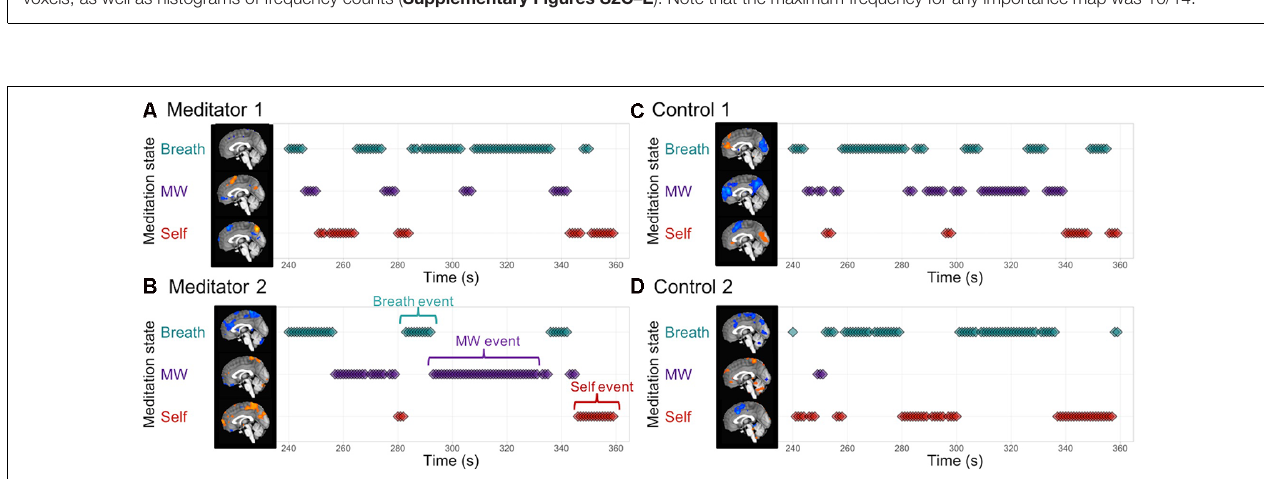
FIGURE 4 | EMBODY Step 2: decoding the internal focus of attention during breath-focused meditation using individualized brain patterns. Based on each participant’s unique brain signatures for Breath, MW, and Self, classifier decisions were made for each time point of fMRI data (TR = 1 s), producing a continuous estimate of attention states during a 10-min breath meditation. The middle of the meditation period is displayed for two meditators (A,B) and their matched controls (C,D) . Mental events were quantified as three or more consecutive decisions from the same mental state (B) and were used to compute metrics of attention during meditation in Step 3. See “Materials and Methods” section and Supplementary Information (SI) p. 4 and Supplementary Table S4 for details and alternate data reduction of classifier evidence and